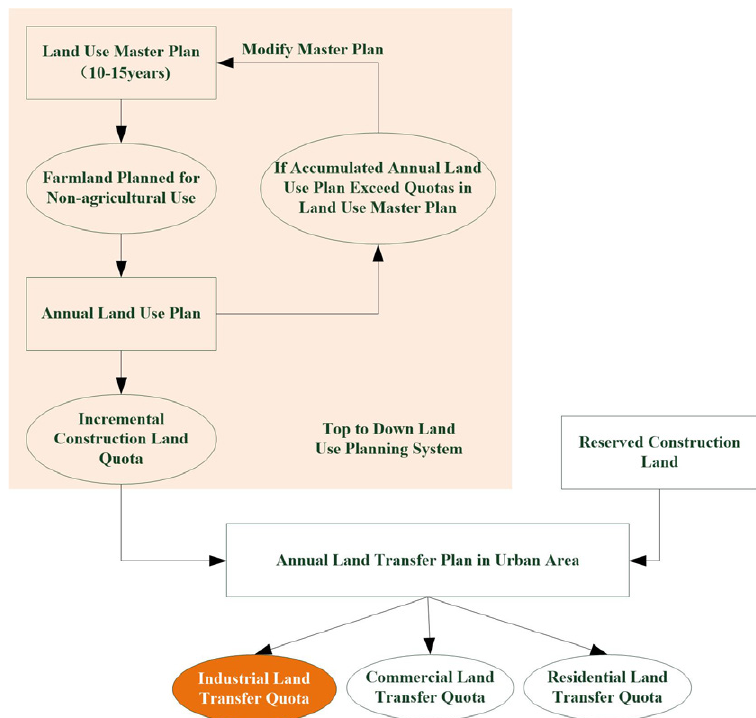
Figure 2. Formulation of industrial land quotas in the Annual Urban Land Transfer Plan